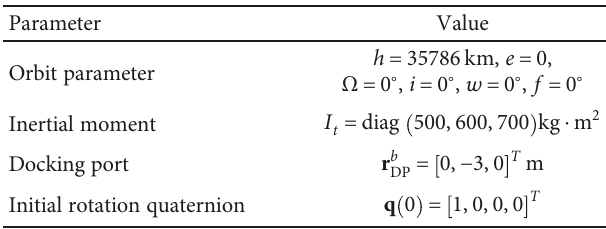
Table 1: Parameters of the failed